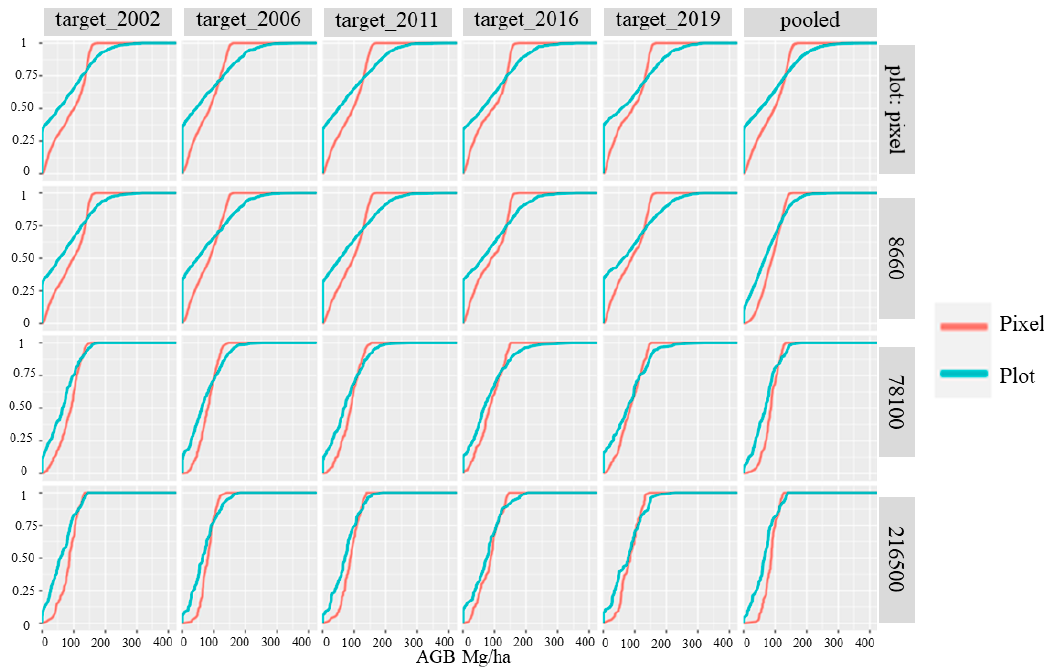
Figure 10. ECDF comparisons across scales—FIA plots vs. mapped (SI-corrected).